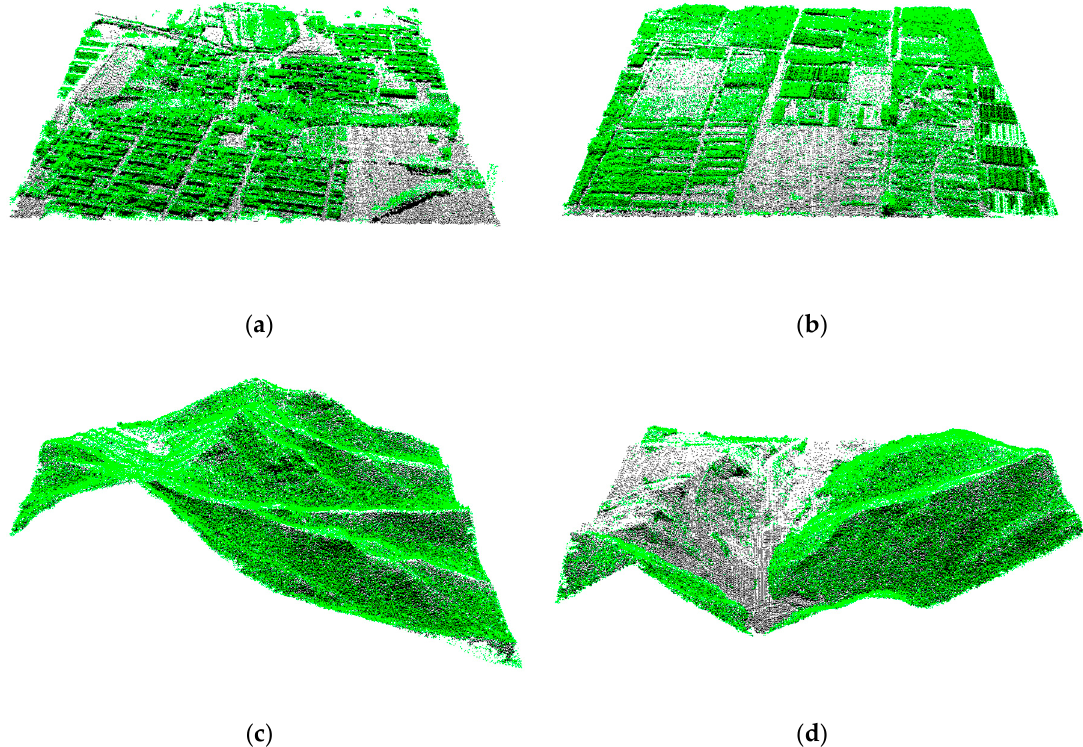
Figure 4. Four examples of the training ALS point clouds with different terrain features: ( a , b ) flat terrain with buildings and farmland; ( c , d ): mountainous terrain. White denotes the ground points, and green denotes the non-ground points.